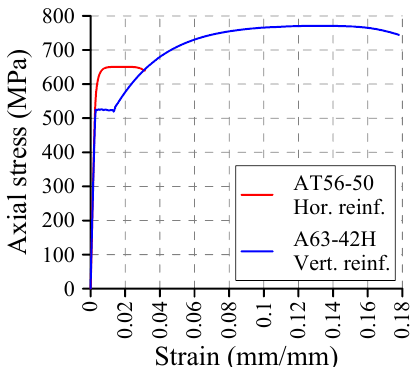
Figure 5. Typical axial response of steel reinforcement.